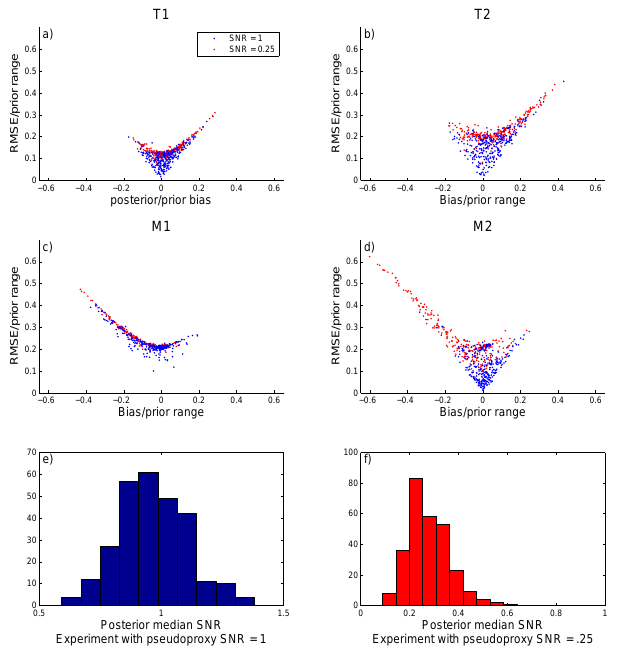
Fig. 2. (a–d) root-mean-squared error versus bias of parameter esti- mates in the pseudoproxy experiment, with both statistics shown relative to the length of each prior’s support for the PPE with SNR=0.25 (red) and SNR=1 (blue). Note that the structure in the scatter plots is a result of the fact that by definition RMSE (X) = q Var (X) + Bias 2 (X) . (e) Histogram of median posterior estimated signal-to-noise ratio (SNR) across all 277 sites, for the pseudoproxy experiment where the true SNR=1. (f) As in (e) but for the experi- ment with